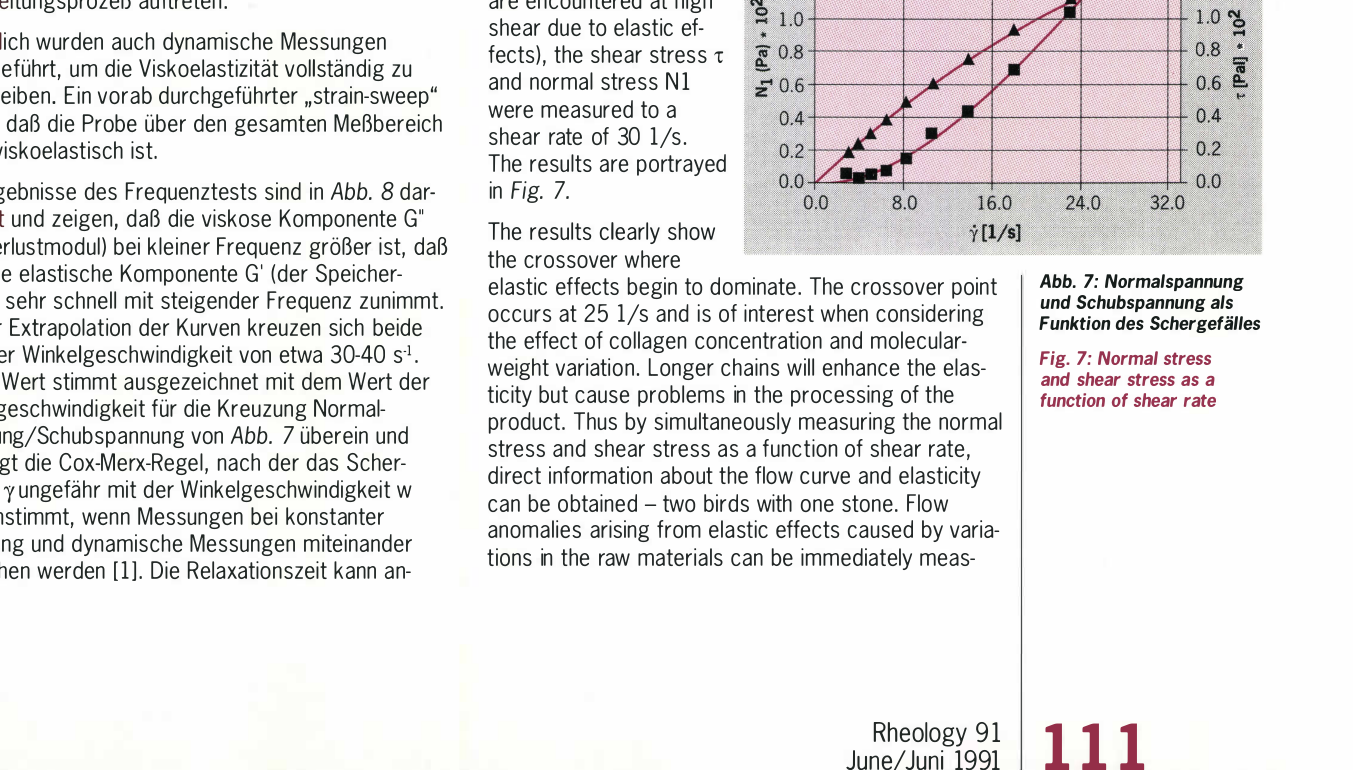
Fig. 7: Normal stress and shear stress as a function of shear rate